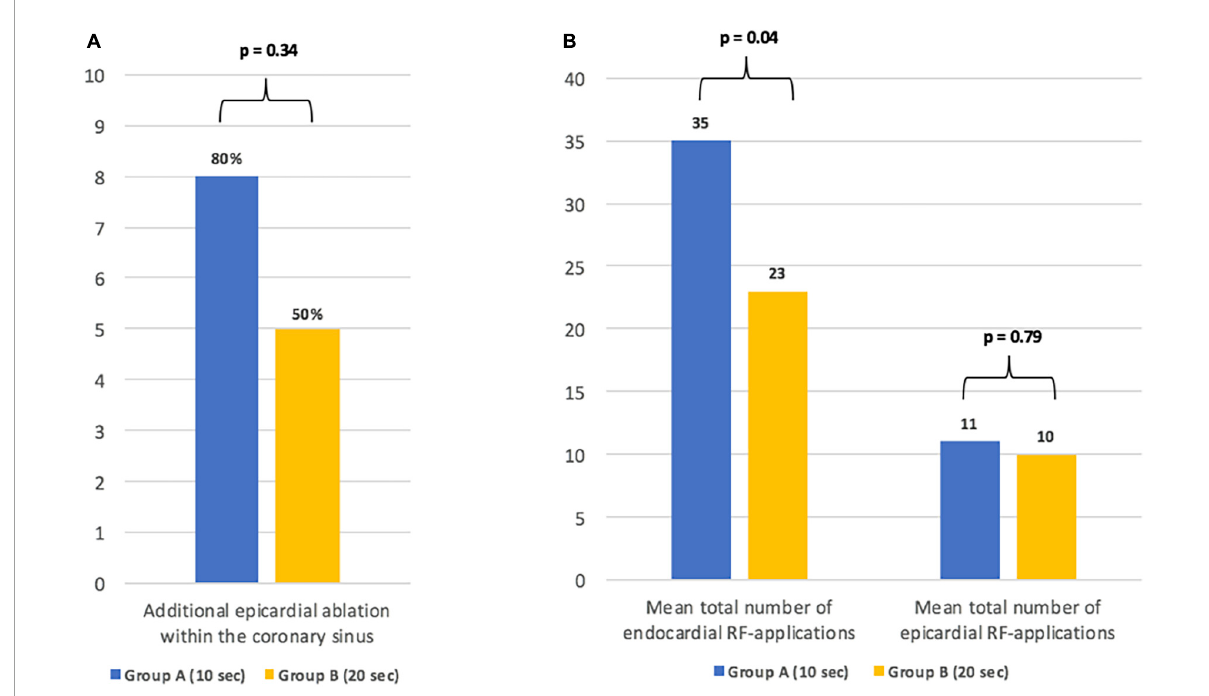
FIGURE2 Details on the need for additional epicardial ablation (A) and the total number of endo- and epicardial radiofrequency-applications until bidirectional conduction block of the mitral isthmus line (B)